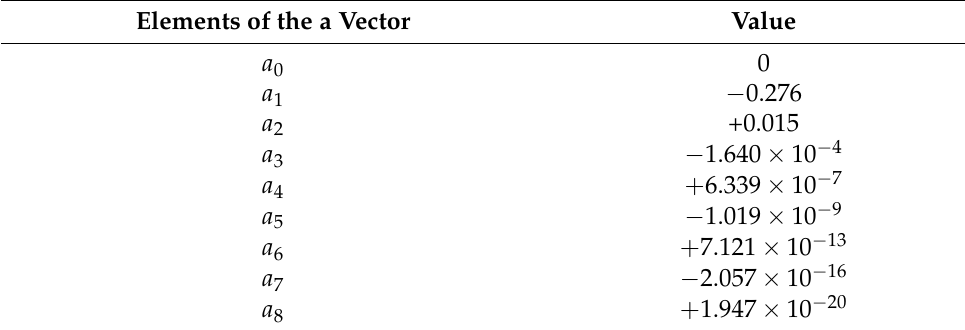
Table 1. Elements of the a vector, fully characterizing the candidate function resulting from the classic Vandermonde approach.